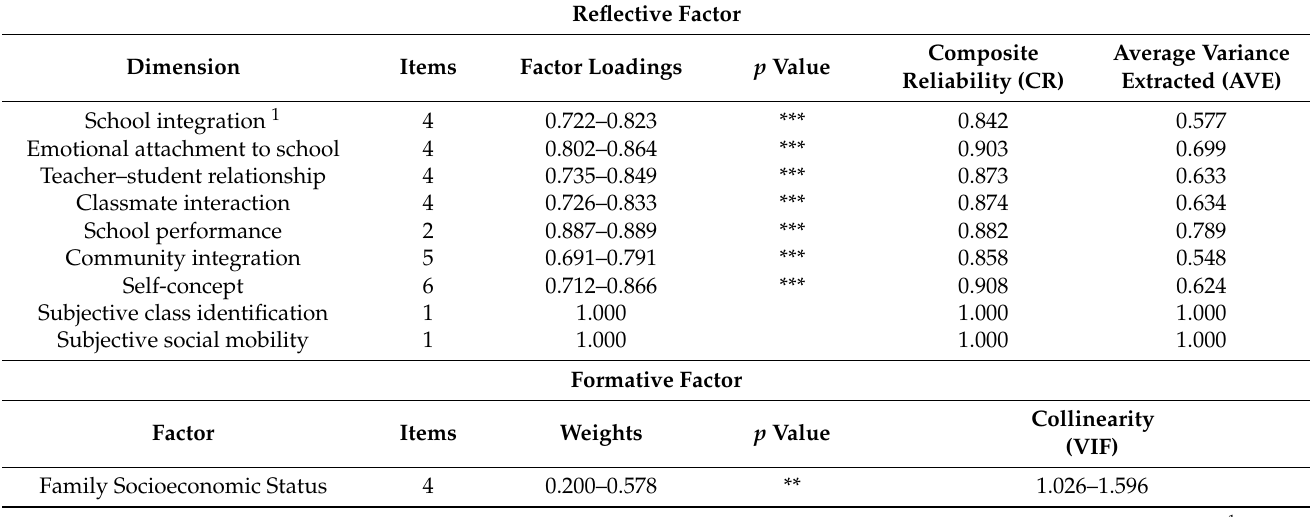
Table 2. Factor characteristics of the measurement model: reliability and convergence